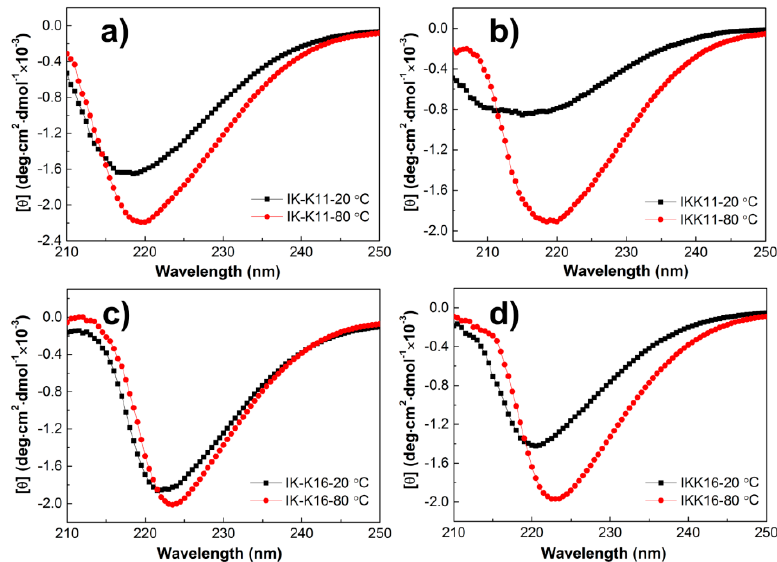
Figure 3. The CD spectra of different peptide solutions at concentration of 4.0 mM and temperature of either 20 °C or 80 °C.